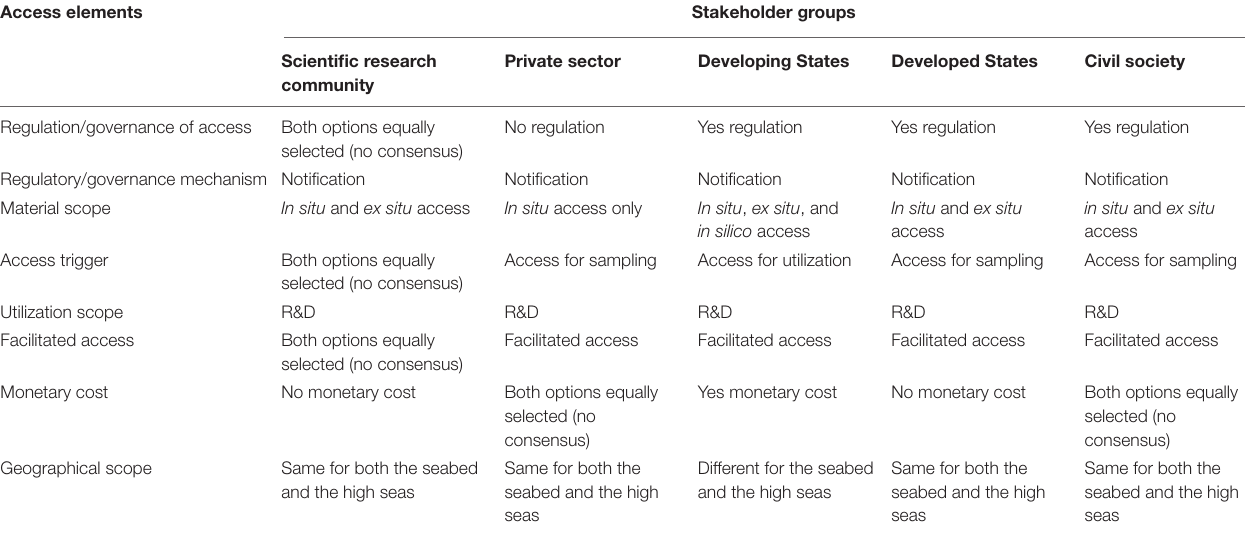
TABLE 3 | Stakeholder perspectives on access options for a potential new genetic resource mechanism for ABNJ.